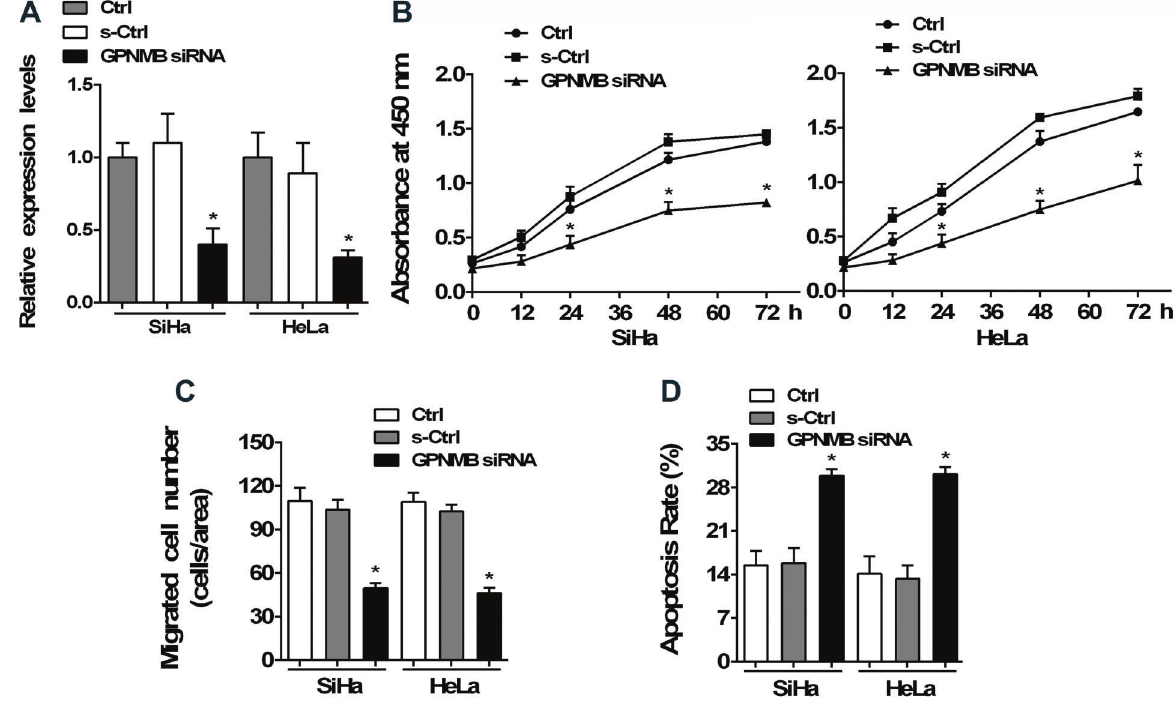
Figure 2. SiHa and HeLa cells were cultured in normal medium (Ctrl), then transfected with glycoprotein nonmetastatic melanoma protein B (GPNMB) siRNA or negative control siRNA (s-Ctrl). A , RT-PCR assay was performed to evaluate the transfection ef fi cacy of speci fi c GPNMB siRNA in cervical cancer cells. B , CCK-8 assay was conducted to clarify the proliferation of SiHa and HeLa cells after treatment with siRNA or not. C , Migration capacity of cells evaluated by Transwell Boyden chambers. D , Apoptosis of cells was measured by fl ow cytometry. Data are reported as means ± SE. *P o 0.05 vs Ctrl